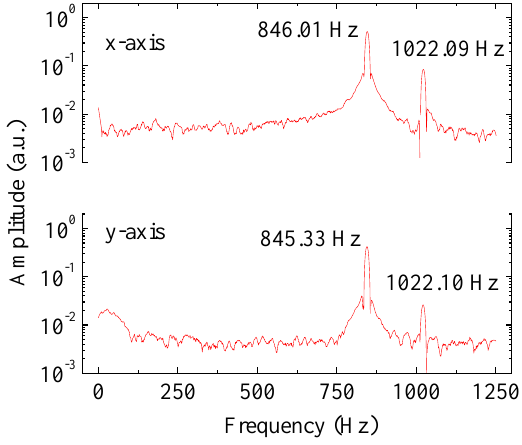
Figure 3. Frequency response of the accelerometer for both sensitive